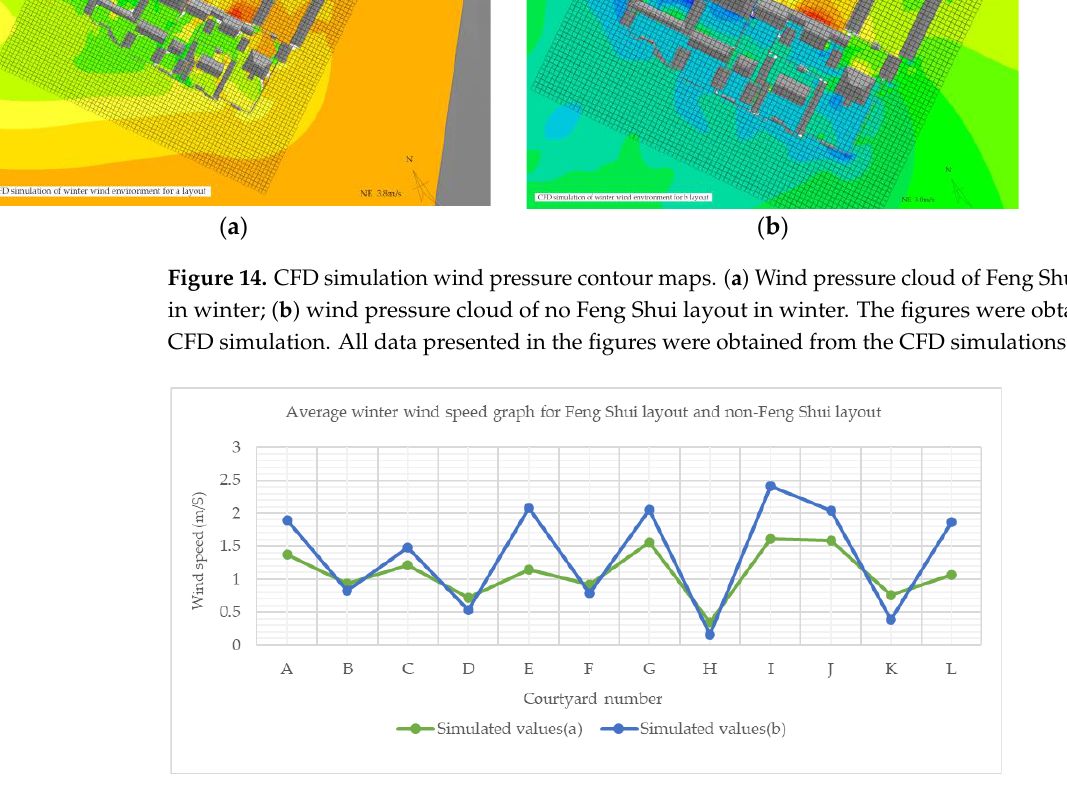
Figure 15. The line graph depicts the average wind speeds of courtyards under Feng Shui and non- Feng Shui layouts. The data for the graph were obtained through CFD simulations.